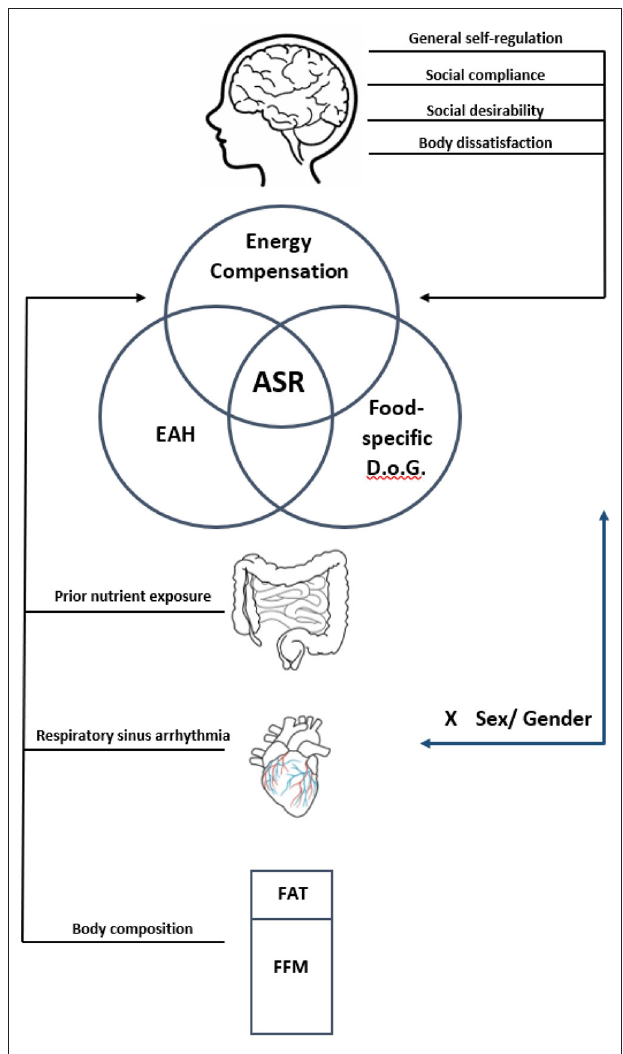
FIGURE 1 | Dual-process model of psychosocial and physiological factors hypothesized to influence ASR. This study posits that ASR involves both bottom-up and top-down processes that may be influenced by a variety of factors. ASR itself is to be operationalized using common paradigms to assess energy compensation, eating in the absence of hunger (EAH) and food-specific delay of gratification (D.o.G). The factors hypothesized to influence bottom-up processes include previous exposure to non-nutritive sweeteners, respiratory sinus arrythmia, and body composition, specifically the ratio of fat mass to fat-free mass (FFM). Top-down influences to be tested include measures of general self-regulation including social compliance and social desirability, as well as body dissatisfaction. We also hypothesize that child sex, which may play a role in ASR, may also be associated with differences in both top-down and bottom-up influences on